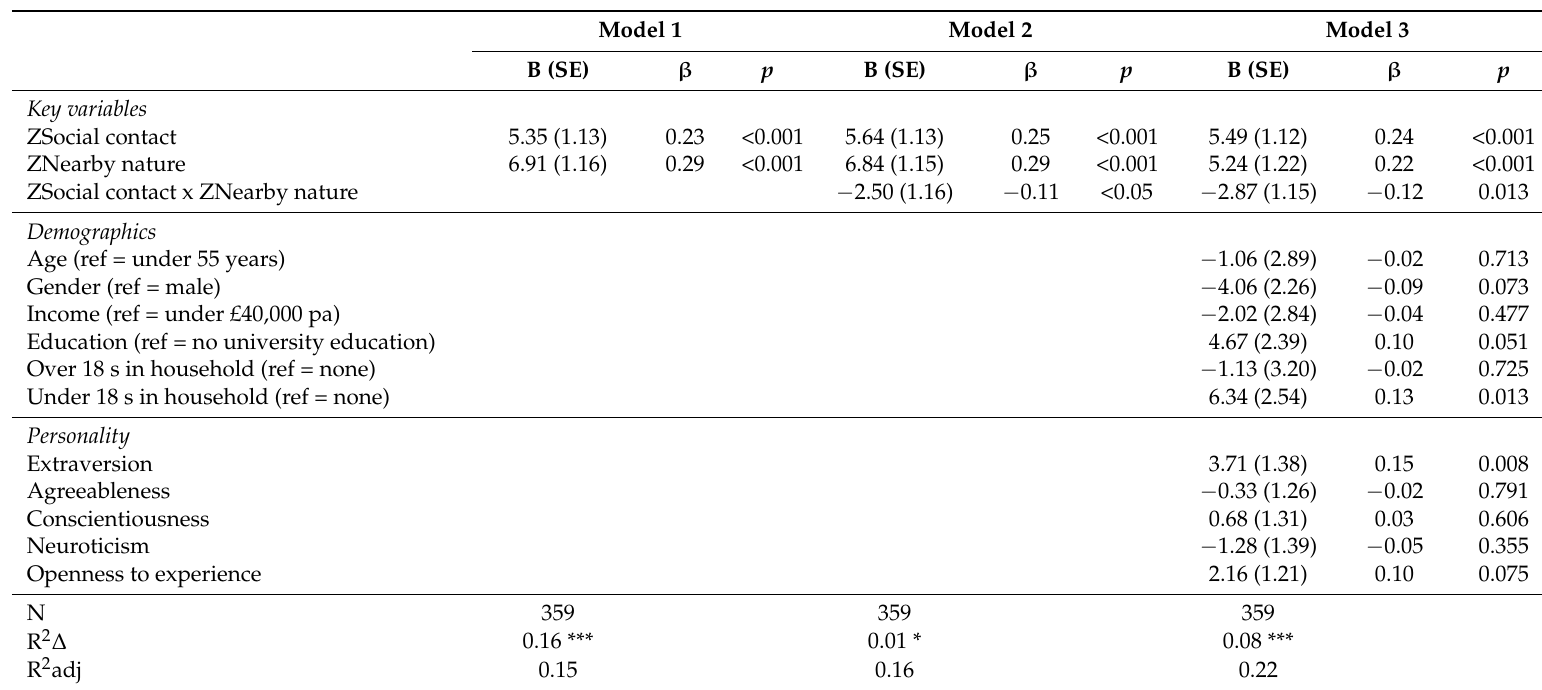
Table 2. Nearby nature*Social contact. Results of multiple regression predicting subjective wellbeing, displaying: unstandardised regression coefficients (B); standard error (SE); standardised regression coefficients ( β ); and, significance ( p ) of